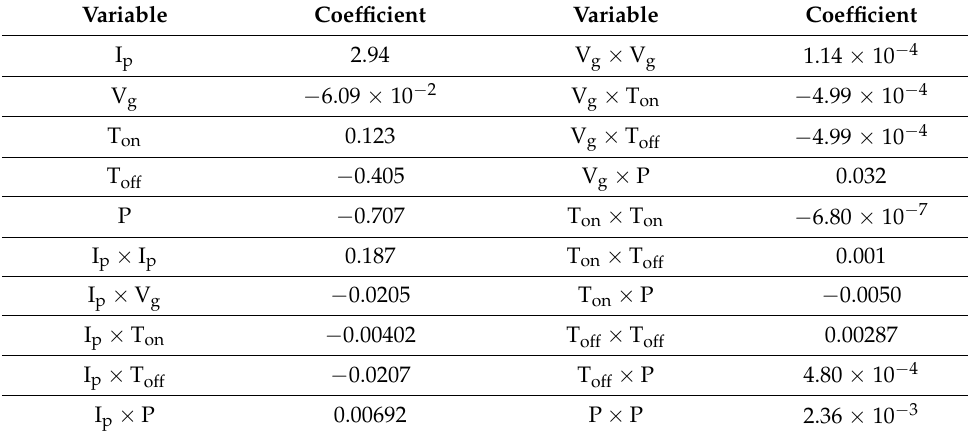
Table 5. Coefficients of variables for change in OOR